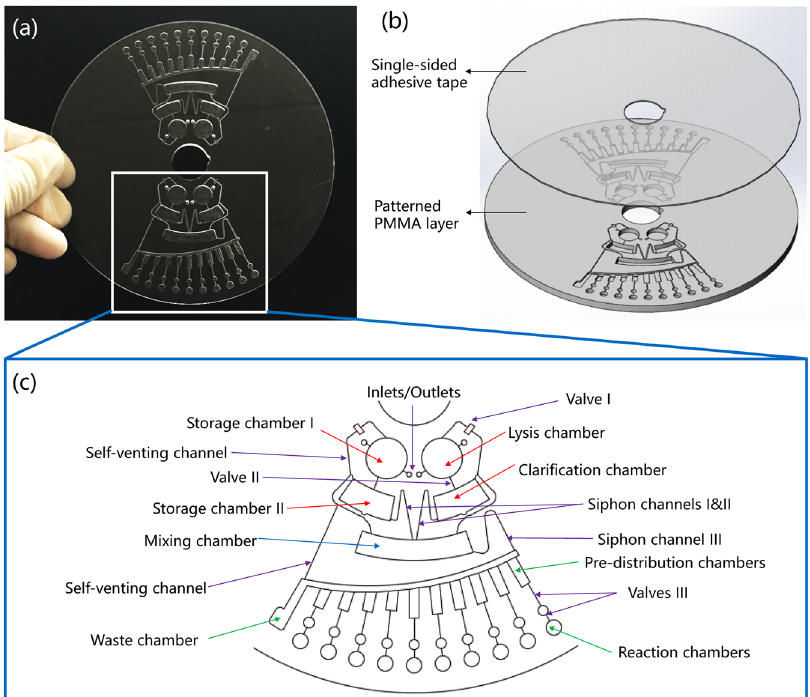
Figure 1. Schematic of the centrifugal chip for detection of bacteria. ( a ) Photo of the chip, which includes two parallel testing sections; ( b ) 3D illustration of the chip. ( c ) Each testing section comprises of four units: the lysis/ clarification and storage unit, the mixing unit, the pre-distribution/reaction unit, and the liquid control unit, indicated by red, blue, green, and purple arrows,